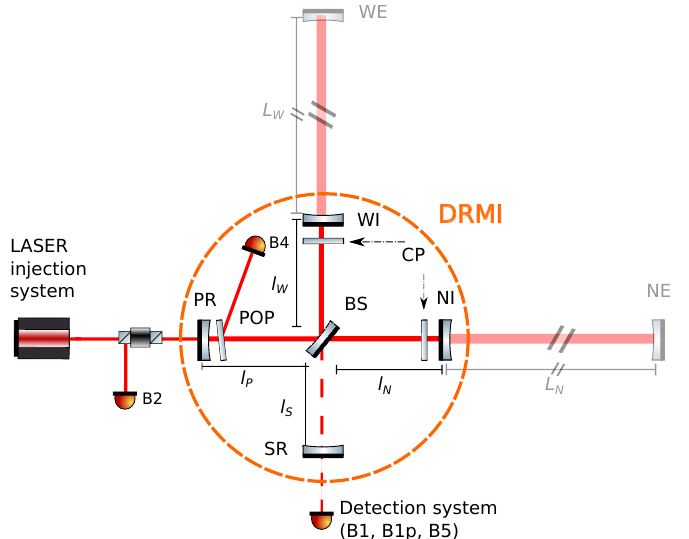
Figure 1. Simplified optical layout of AdV+, including the DRMI. The DRMI is circled in orange and includes the Power Recycling (PR), Signal Recycling (SR), North-Input (NI) and West-Input (WI) mirrors, and the Beam-Splitter (BS). The full interferometer, in its Dual-Recycled Fabry-Pérot Michelson Interferometer (DRFPMI) configuration, would also include the 3km-long Fabry-Pérot arm cavities by the addition of the North-End (NE) and West-End (WE) mirrors. The figure also includes the position of the main photodetectors monitoring the DRMI beams: B2 (reflection from the PRC), B4 (intra-cavity pickoff of PRC), B1p (antisymmetric port pickoff), B1 (antisymmetric port beam after the output mode cleaner), B5 (stray-beam generated by the BS anti-reflective